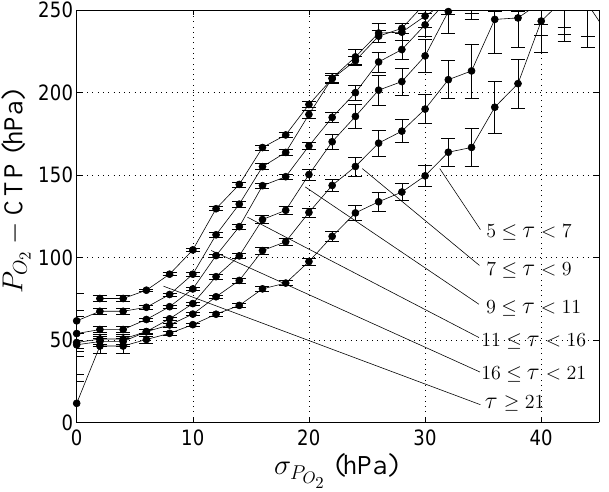
− CTP (the difference between Fig. 7. Relationship between P O 2 POLDER oxygen pressure and CPR/CALIOP cloud top pressure) and the angular standard deviation of POLDER oxygen pressure σ P , on average in 2008 and for different classes of optical thick- O2 ness τ . Case of liquid water clouds over ocean, and for a particular solar condition: 0 . 7 ≤ µ s ≤ 0 . 8. Standard deviations are also shown with error